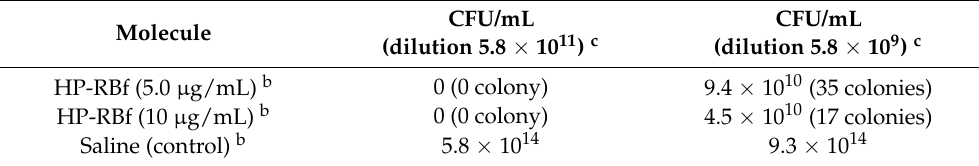
Table 3. CFU after the treatment of HP-RBf for air-exposed biofilms of S. aureus BAA-44 TM a